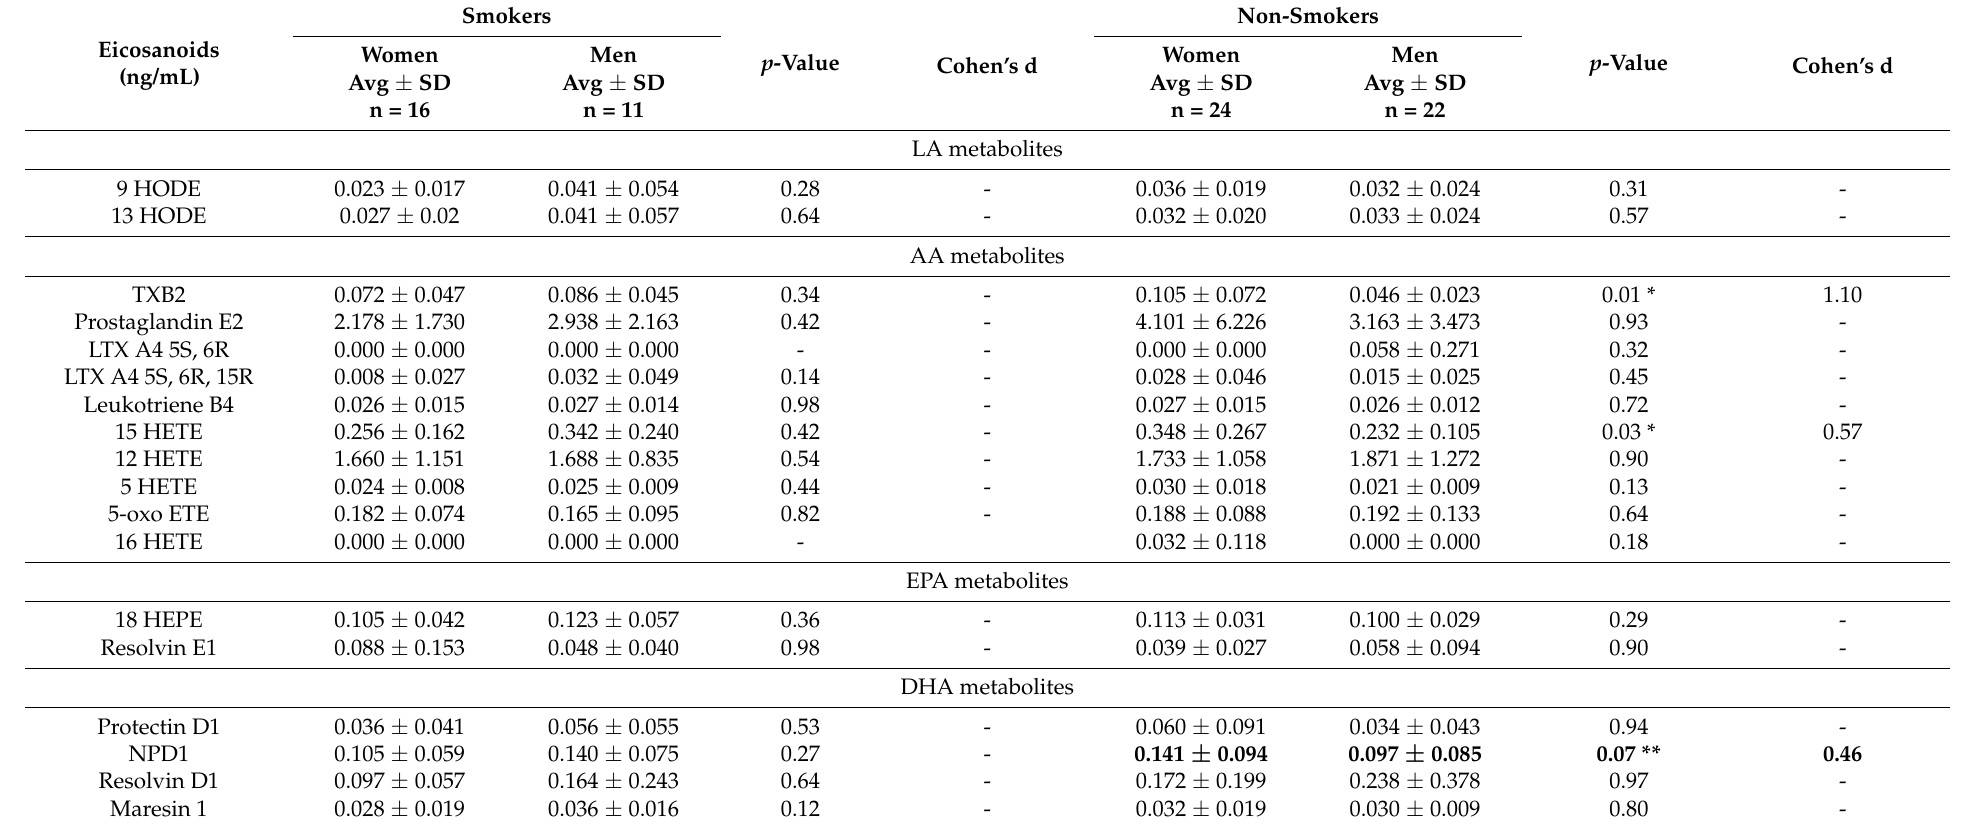
Table 3. Eicosanoid levels in smokers and non-smokers, including